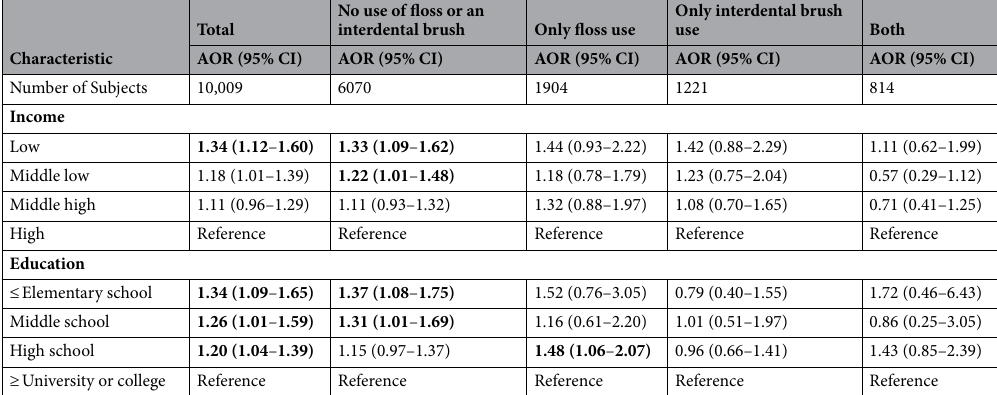
Table 4. Multivariable association between socioeconomic status and periodontitis in the entire sample stratified by floss and interdental brush. AOR adjusted odds ratio, CI confidence interval. Bold denotes statistical significance at P <